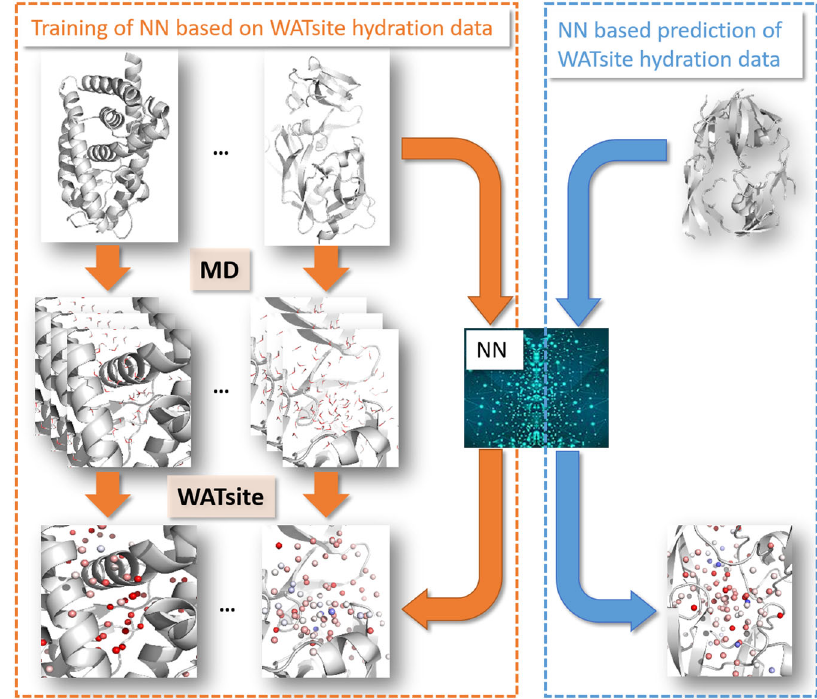
Fig. 1 Overall idea of WATsiteOnTheFly. A neural network is trained to generate thermodynamic hydration data based on static protein structure. This allows ef fi cient calculation of (de)solvation data without performing MD